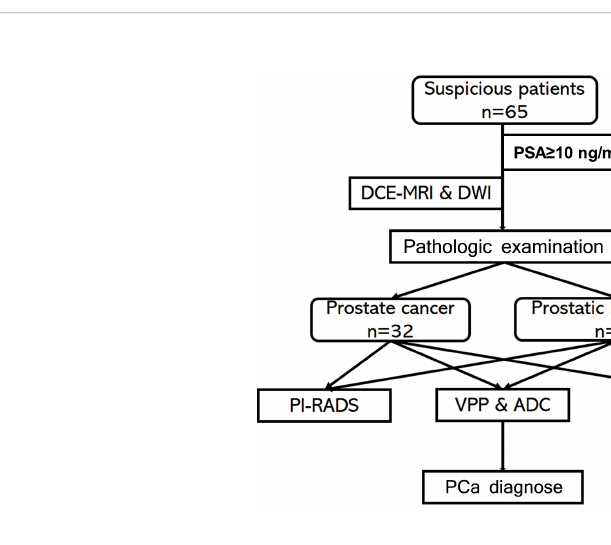
FIGURE 1 Flow diagram of the study